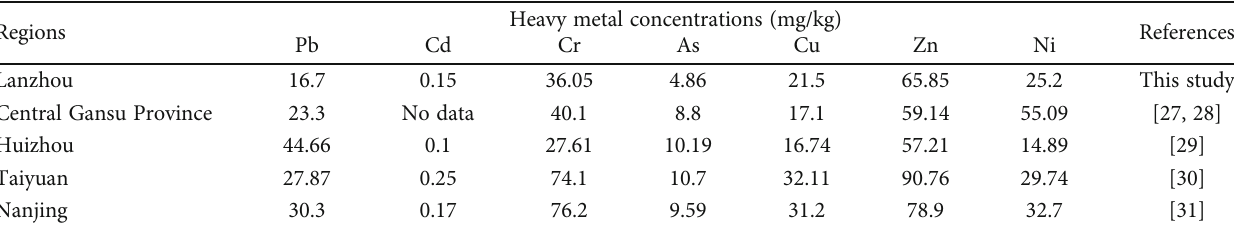
Figure 4: Biplot is showing the scores of di ff erent site samples and the loading of 7 heavy metals. Table 8: Summary of heavy metal concentrations of di ff erent cities in